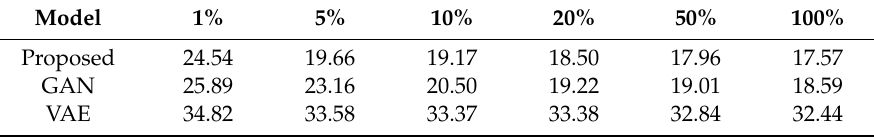
Table 7. FD001 RMSE Unsupervised Feature Learning—Random Labeling Intervals.